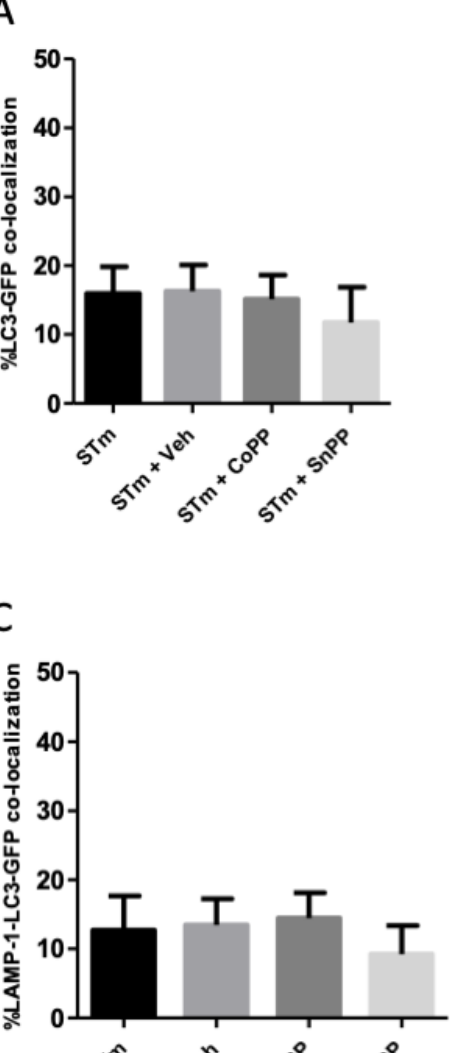
Figure 6. Co-localization of S . Typhimurium-GFP with autophagosome and lysosome markers in infected RAW264.7 cells. RAW264.7 cells were infected with STm-GFP for 1 h and subsequently treated for 4 h in the presence of vehicle (NaOH), CoPP, or SnPP. LC3: red; LAMP-1; magenta; DAPI: blue. STm-GFP colocalization with both markers is shown in white arrowheads. Scale Bar: 10µm. Images are representative of two independent experiments.